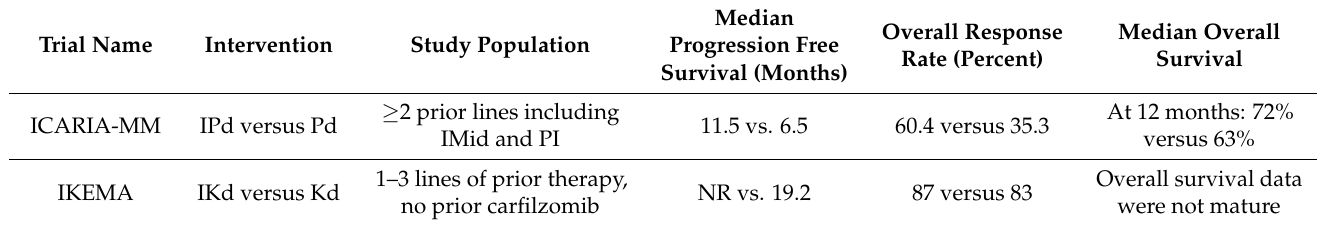
Table 4. Summary of Major Clinical Trials Leading to FDA Approval of Isatuximab.